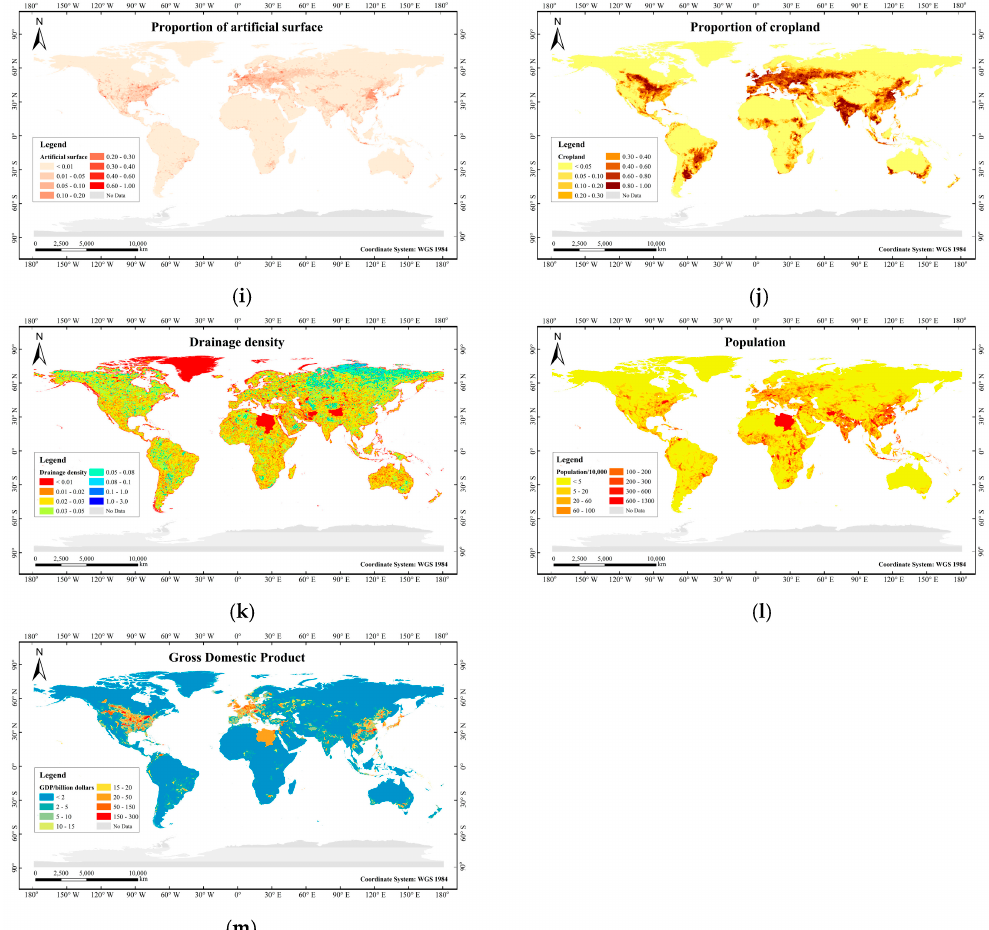
Figure 2. Conditioning factors of this study: ( a ) maximum daily precipitation (MDP), ( b ) precipitation concentration degree (PCD), ( c ) altitude, ( d ) slope, ( e ) relief degree of land surface (RDLS), ( f ) soil type (ST), ( g ) Manning coefficient (MC), ( h ) proportion of forest and shrubland (PFS), ( i ) proportion of artificial surface (PAS), ( j ) proportion of cropland (PC), ( k ) drainage density (DD), ( l ) population, and ( m ) gross domestic product (GDP).